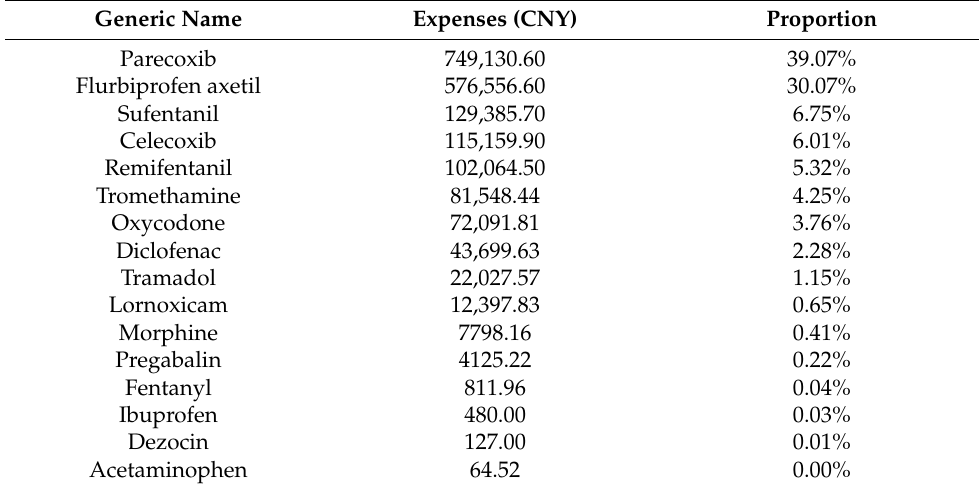
Table 7. Analgesic drug